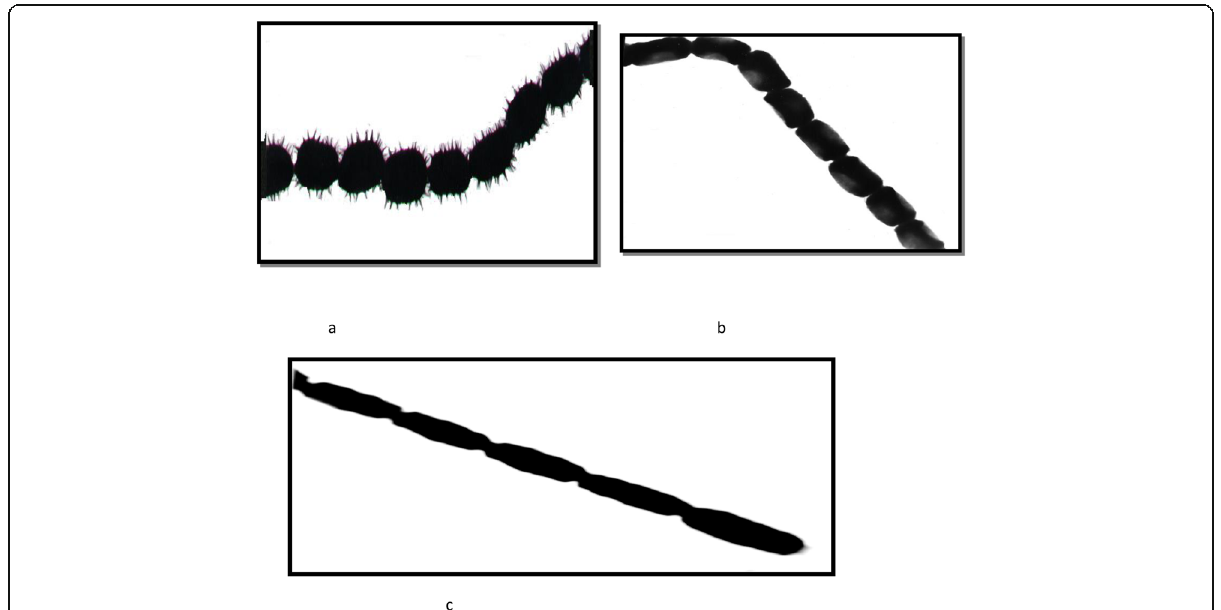
Fig. 2 Different types of spore surface of Streptomyces sp. a (spiny), b (smooth), and c (warty)